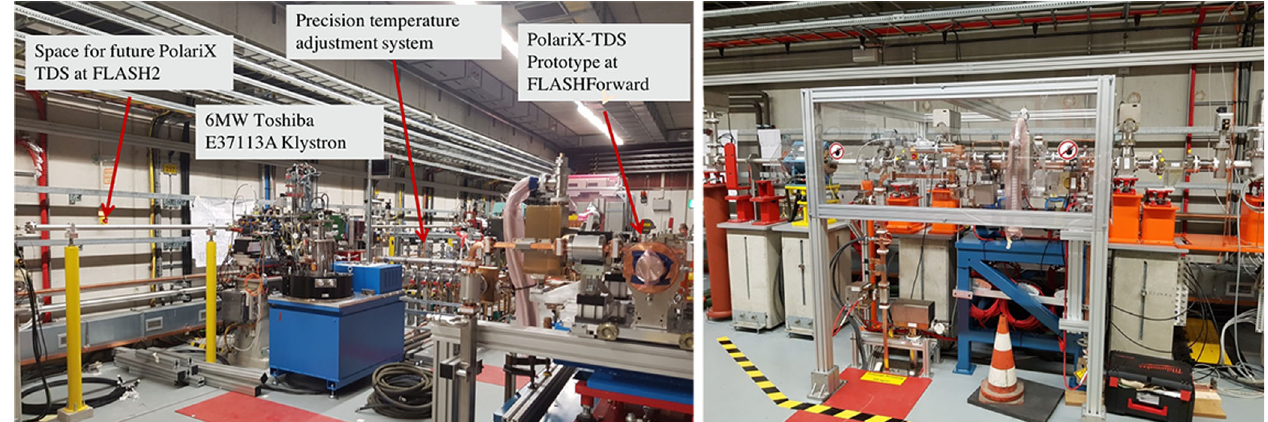
FIG. 35. Installation of the Prototype PolariX-TDS at DESY in FLASHForward tunnel. The Ampegon Type M-Class Modulator is located outside of the tunnel and is connected to the Canon klystron via an about 12 m long high-power